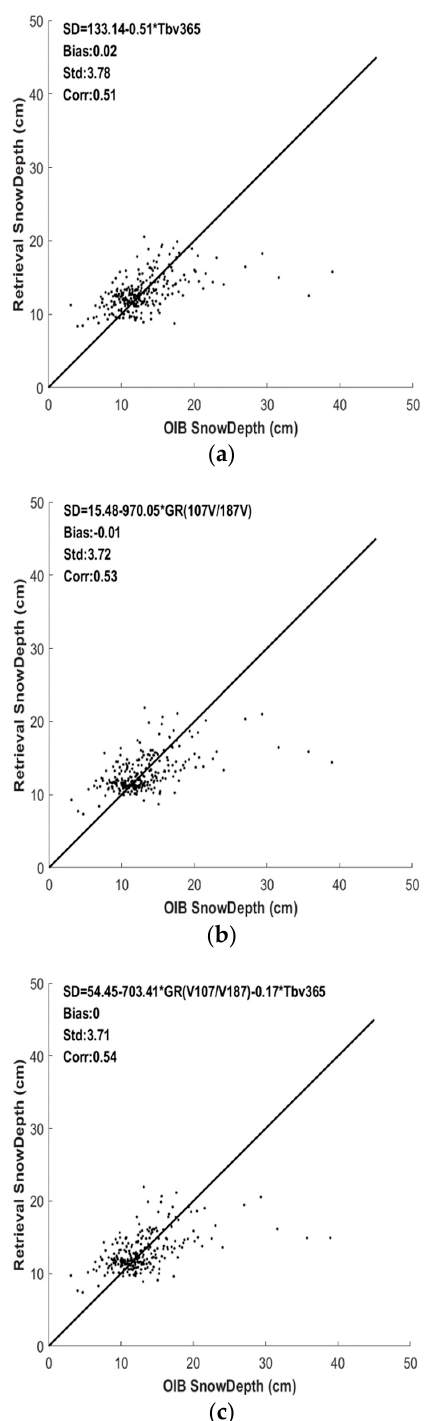
Figure 11. Calculated snow depths versus those from OIB data (FYI). ( a – c ) correspond to Equa- tions (2)–(4),